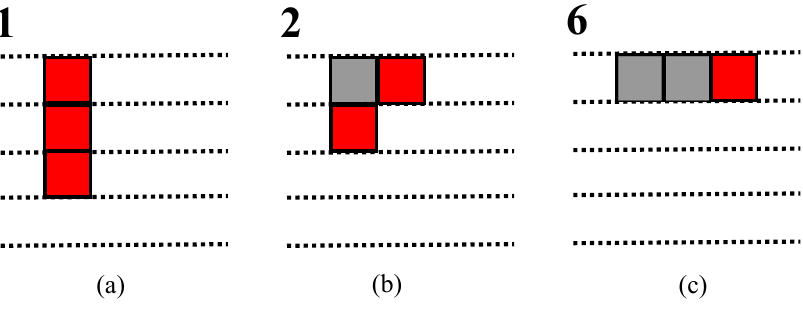
Figure 1 . Tableaux for the coefficients appearing in this example. The red tiles in the tableaux are allowed to perform a permutation among the rows. The meaning of such permutations are to be discussed